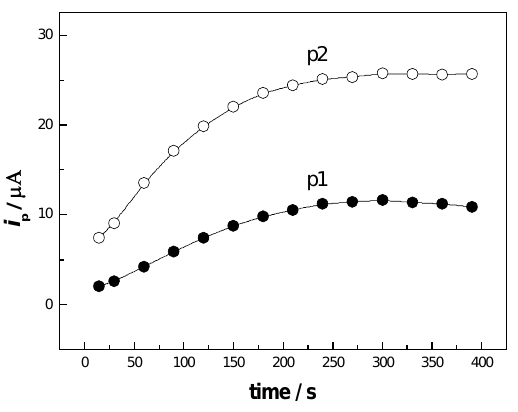
Figure 4. Effect of the accumulation time on the anodic peak currents of 5.0 × 10 -7 M meloxicam in the B-R buffer solution (0.04 M, pH 1.86). Scan rate: 100 mV·s -1 ; accumulation potential: -0.2 V; quiet time: 30 s.